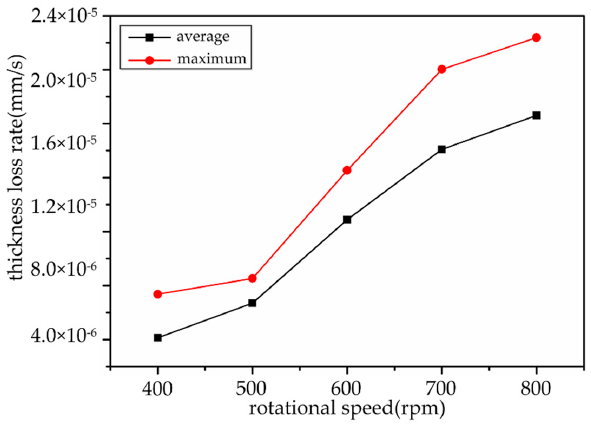
Figure 13. Thickness loss rate at the exit area A of the blade working face at an 8% mass